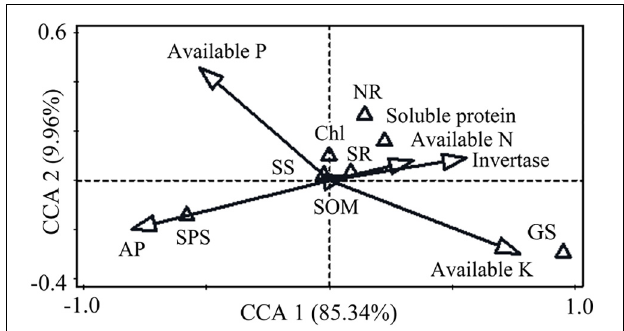
FIGURE 2 | Canonical correspondence analysis (CCA) of the relationship between soil properties and leaf physiological attributes. Soil factors are represented by hollow arrows. Leaf attributes are represented by hollow triangle. The first axis (horizontal) and the second axis (vertical) explained 85.34 and 9.96% of the variation. SR, soluble sugar; Chl, chlorophyll.